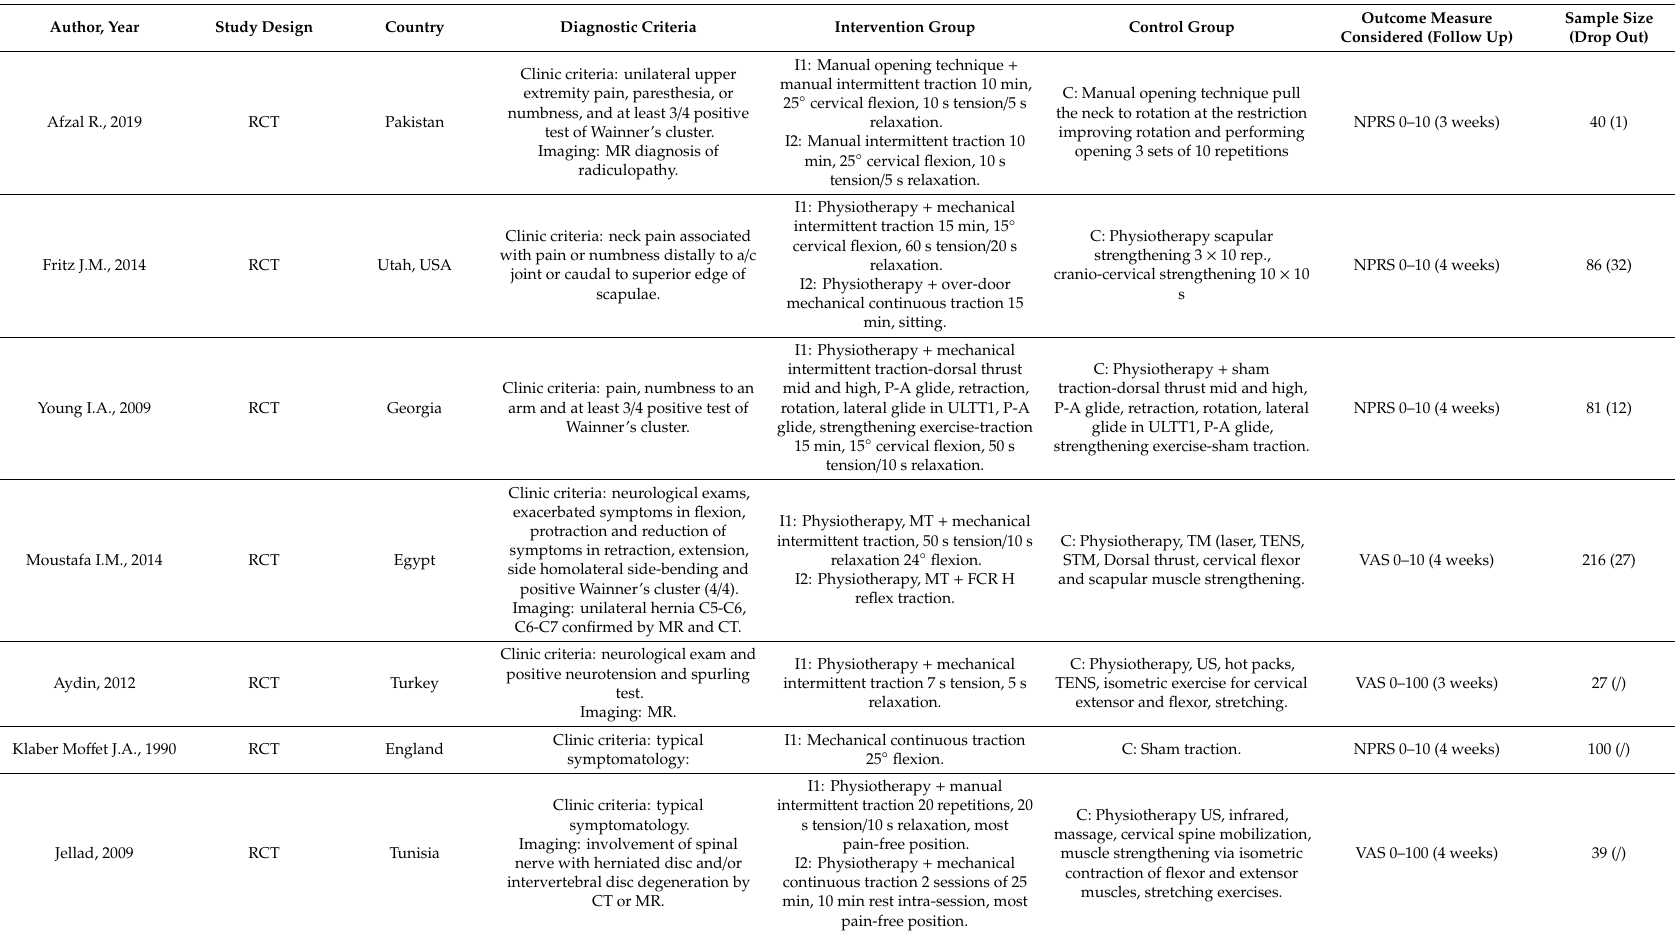
Table 1. Study characteristics.